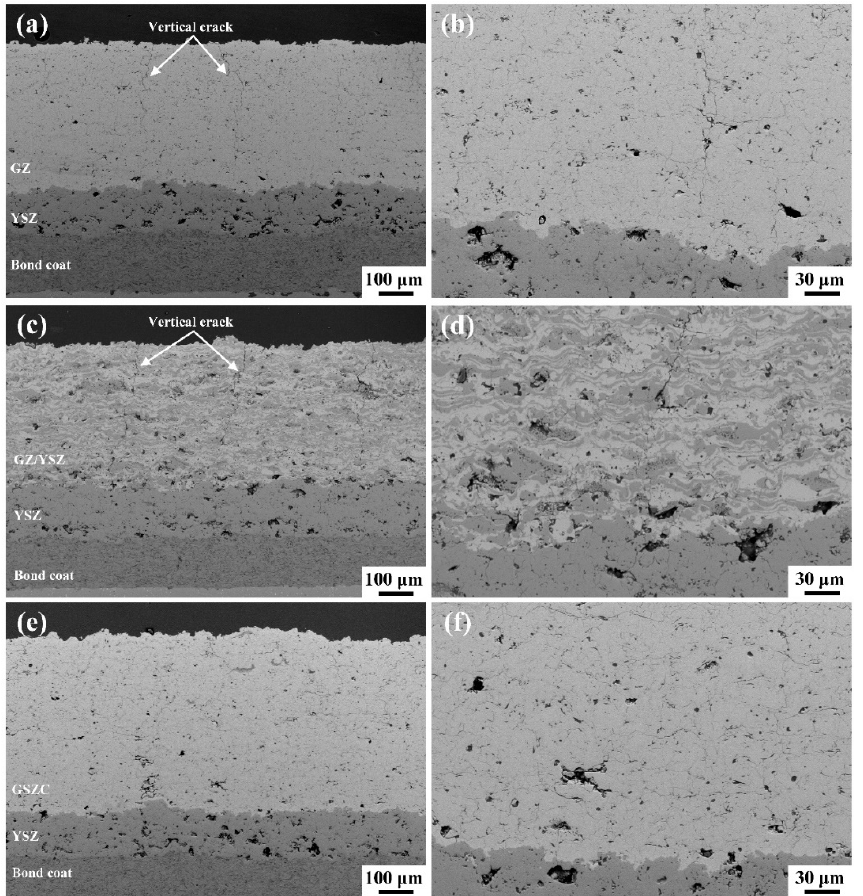
Figure 4. Cross-sectional morphologies of the as-sprayed ( a , b ) GZ, ( c , d ) GZ/YSZ, and ( e , f ) GSZC TBCs.